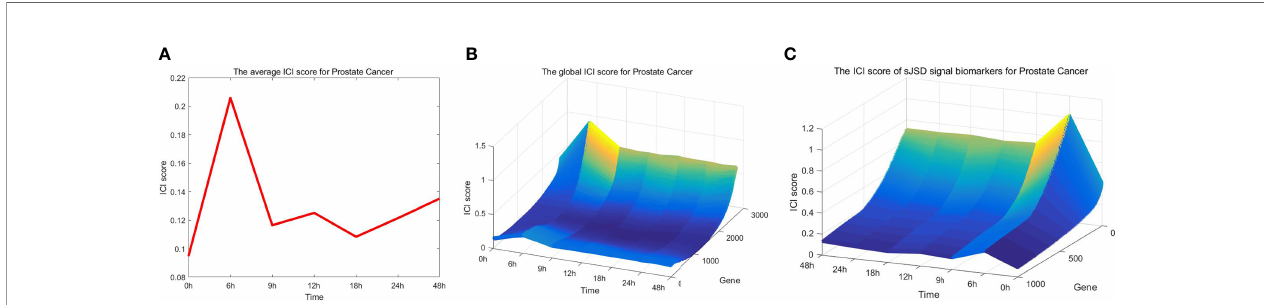
FIGURE 3 | Application of sJSD method in prostate cancer. (A) The curve of average ICI score for prostate cancer. The average ICI score peaks at the 6th hour. It can be viewed as an early-warning signal of critical transition for prostate cancer. (B) The landscape of the global ICI score. The dynamical change of global ICI scores proves the arrival of the critical transition from a single gene ’ s perspective. (C) The landscape of ICI scores of sJSD signal biomarkers. The ICI scores of sJSD signal biomarkers increase signi fi cantly at the 6 th hour with a more ( Supplementary Table S1 ). The relationship between the high- frequency genes and the pathogenesis of prostate cancer or cancer are exhibited in Table 1 . For instance, in the current sample, the genes GNAS, GNAQ, and GNA11 were widely altered across cancer types, and these alterations often were accompanied by speci fi c genomic abnormalities in AURKA, CBL, and LYN (20). HDAC4 is recruited to the nuclei of HR cancer cells, where it may exert an inhibitory effect on differentiation and contribute to the development of the aggressive phenotype of late stage CaP (21). Filamin-B (FLNB) was identi fi ed as biomarkers in a strategy for prostate cancer (PrCa) biomarker discovery (22). Reduced